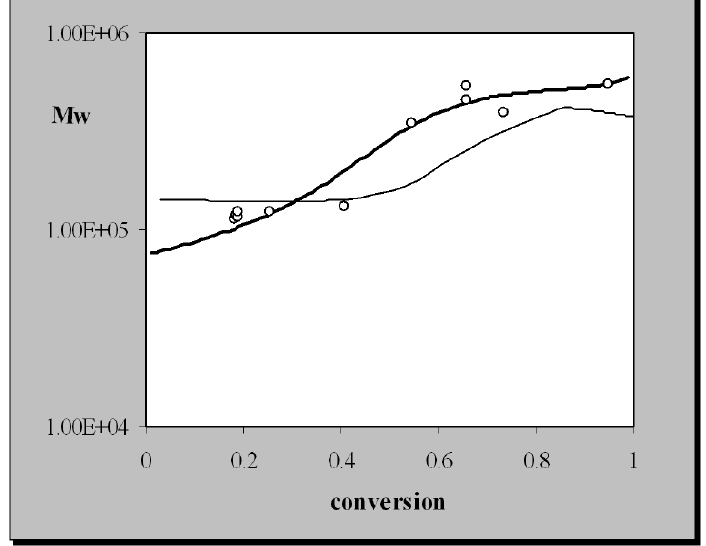
Fig. 11 Weight average molecular weight (logarithmic scale) obtained with MLP (3:10:1) (thick line), by simulation on the kinetic model (thin line) and experimentally (o) [15], [16] at 90 o C and 15.48 mol/m 3 .